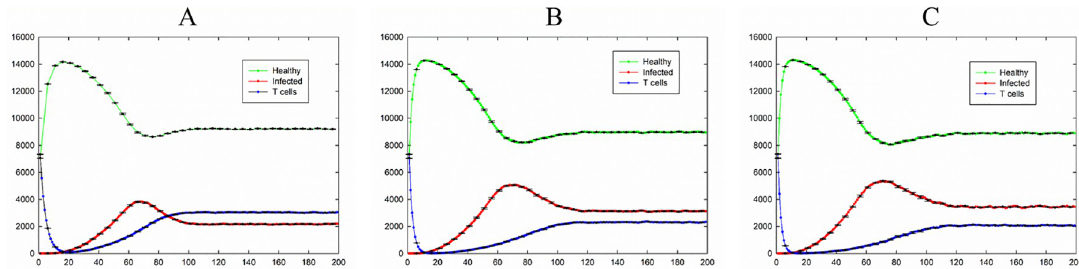
Fig 4. Total number of healthy, infected, and T cells versus time for the case of P I = 0.4, P T = 0.6, and P H = 0.4; A) P D = 0.24. B) P D = 0.36. C) P D = 0.4. Healthy, infected, and T cells are shown in green, red, and blue, respectively. The standard errors are shown by error bars.